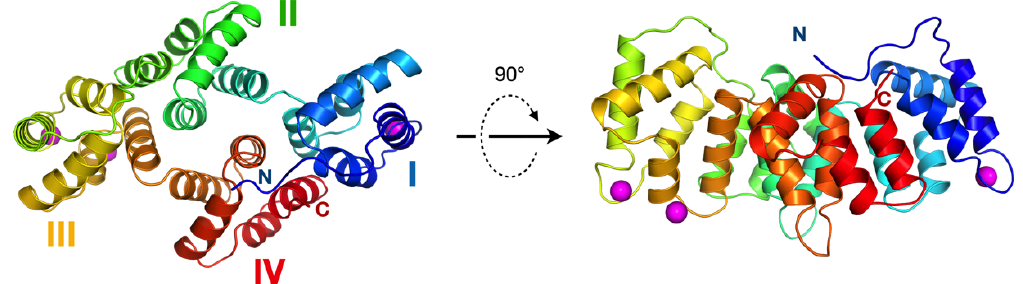
Figure 2. Crystal structure of the AnxA11 core domain. The four subdomains are numbered and coloured from blue to red. The N and C termini are indicated, and bound Ca 2+ ions are shown in magenta. Shown is one monomer of the three in the asymmetric unit.